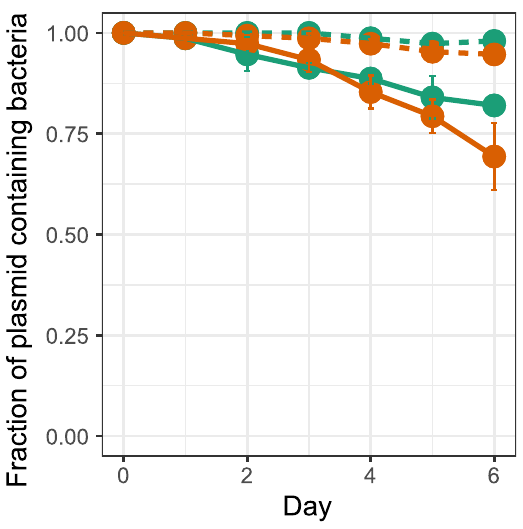
Figure 5. Persistence of ancestral ( ) and evolved pL1_1 plasmid ( ) in the naïve hosts P . putida ( ) and S . japonicum ( ). Data presented for P . putida have been previously published as supplementary information in Yano et al . 33 . Each point is the mean of 3 individual replicates and the error bars show the standard deviation. The plasmid population dynamics model previously described 29, 34, 35 was used to determine if the persistence dynamics of two bacteria-plasmid pairs where similar or not (see Materials and Methods and